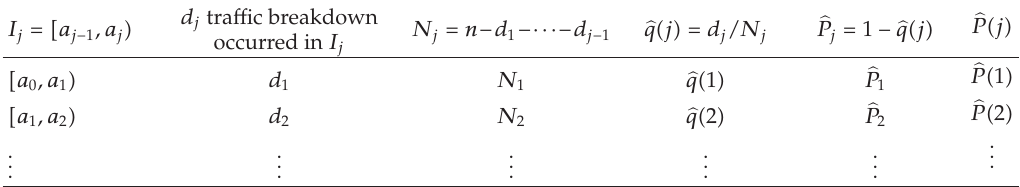
Table 1: Lifetime table for capacity